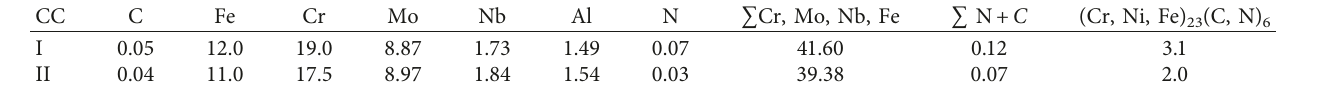
Table 1: Chemical composition of 05Cr19Ni55 alloy (mass %).